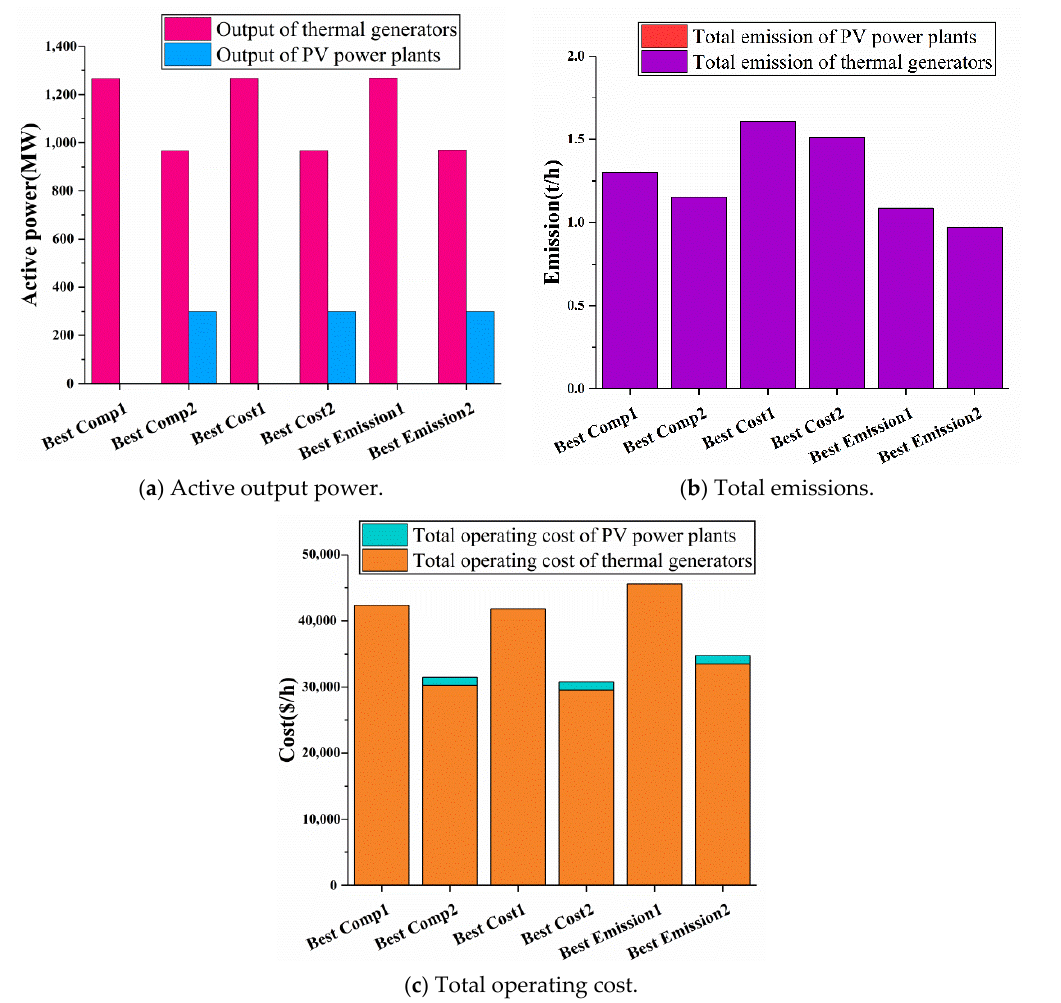
Figure 10. The bus voltages in the three solution scenarios obtained by CMODE for case 2.